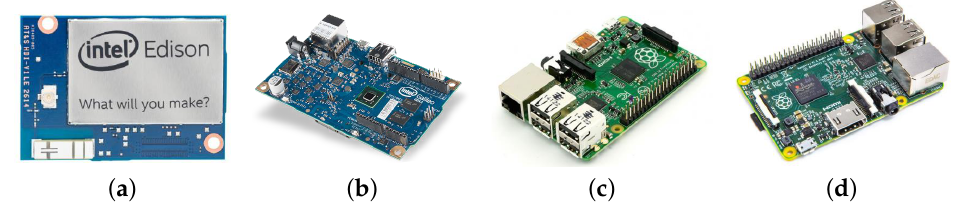
Figure 10. Selected embedded devices. ( a ) Intel (cid:114) Edison; ( b ) Intel (cid:114) Galileo Board Gen2; ( c ) Raspberry Pi1 Model B+; ( d ) Raspberry Pi2 Model B.